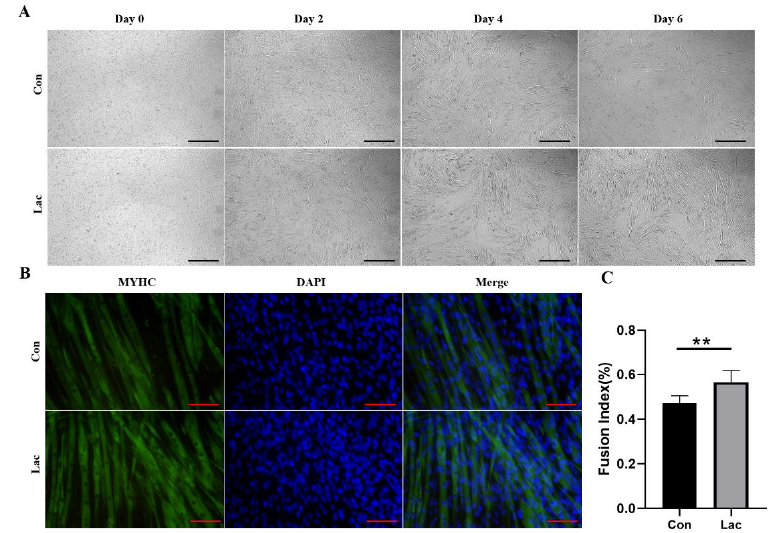
Figure 2. Lactate treatment promoted the myogenic differentiation of myoblasts. Cells were differen- tiated in either a differentiation medium (Con) or a differentiation medium supplemented with 5 mM lactate (Lac). ( A ) Representative morphological images of cells formed after inducing differentiation for the indicated days. Scale bar, 500 µ m; ( B ) Lactate-treated cells and controls formed 7 days after the induction of differentiation were stained with MYHC antibody (green) and DAPI (blue). Scale bar, 20 µ m; ( C ) Fusion index defined as the percentage (%) of nuclei located within MYHC-positive myotubes out of the total number of nuclei ( n = 4). Results are presented as Mean ± SD. ** p < 0.01, for the statistical analysis of Lac vs. Con.